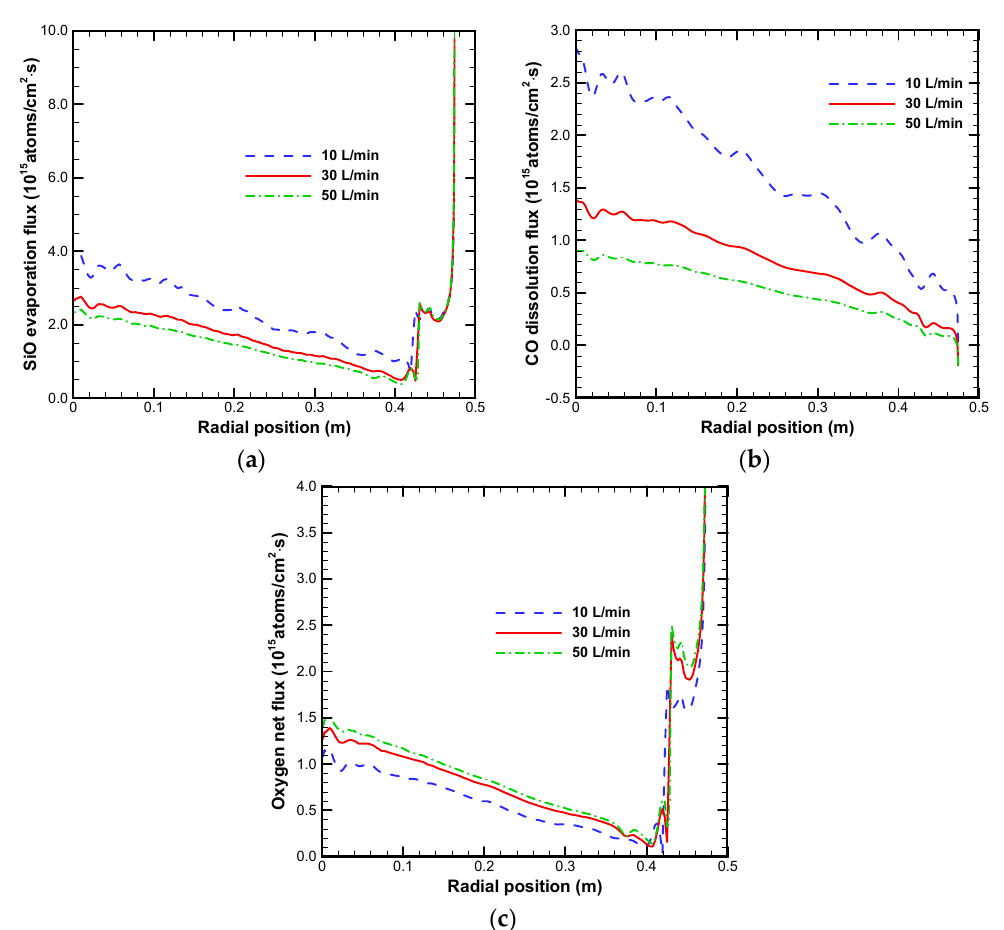
Figure 4. SiO evaporation flux ( a ), CO dissolution flux ( b ) and oxygen net flux ( c ) along the melt–gas surface for different argon flow rates at S.F. = 50%.